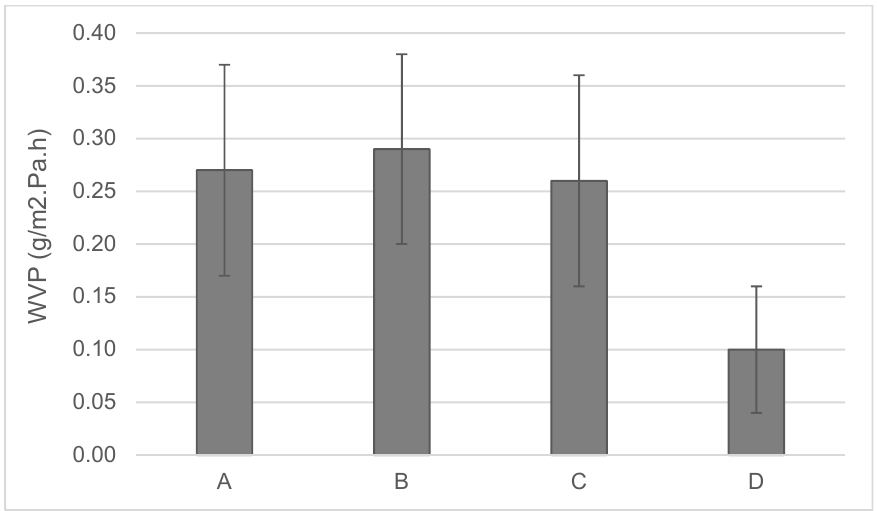
Figure 3. Illustration of the fabrics’ breathability (g/m 2 ·Pa·h).